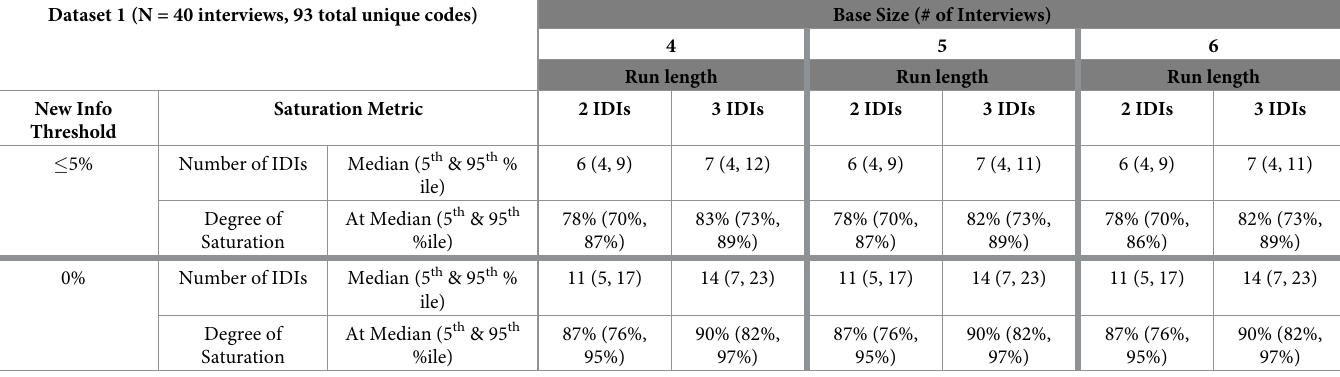
Table 2. Dataset 1 bootstrap distribution: Median number of interviews to reach saturation and degree of saturation at different base sizes and run lengths. Dataset 1 (N = 40 interviews, 93 total unique codes)